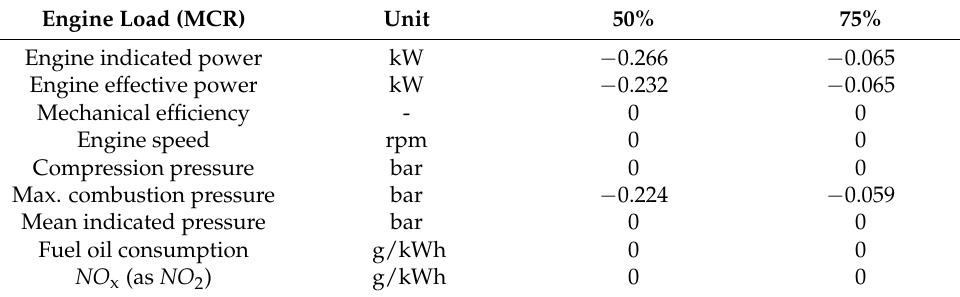
Table 8. Model data deviations from engine acceptance test data [22].